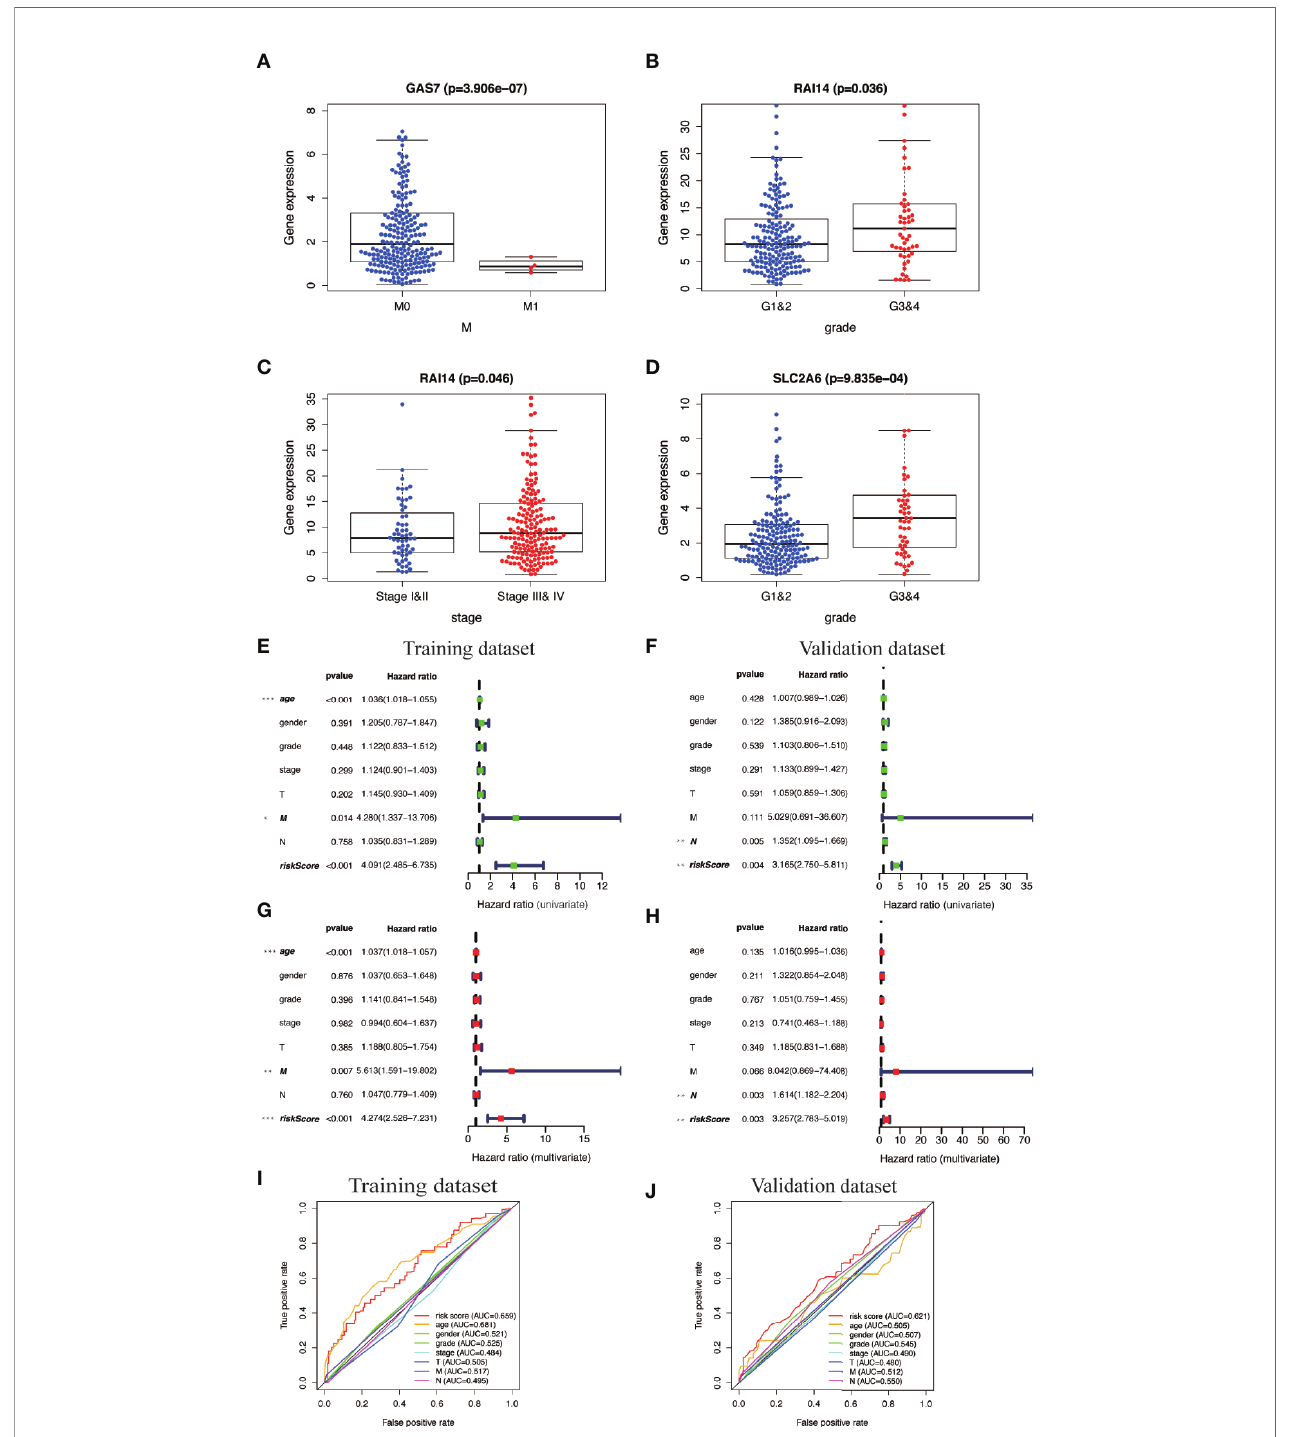
FIGURE 7 | Clinical correlation analysis and independent prognosis analysis of TBGs and clinicopathologic characteristics. (A) Differentially expressed GAS7 in M classi fi cation (M0 and M1). (B, C) Differentially expressed RAI14 in pathologic grade classi fi cation (G1 – 2 and G3 – 4) and TNM classi fi cation (Stage I – II and Stage III – IV). (D) Differentially expressed SLC2A6 in pathologic grade classi fi cation (G1 – 2 and G3 – 4). (E, F) Univariate Cox regression analysis. Forest plot of the association between risk factors and survival of training dataset and validation dataset. (G, H) Multivariate Cox regression analysis. Forest plot of the association between risk factors and survival of training dataset and validation dataset. (I, J) Receiver operating characteristic (ROC) analysis of the sensitivity and speci fi city of the OS for the ten-gene risk score in the training dataset and validation dataset. Note: * P < 0.05, ** P < 0.01, *** P < 0.001, **** P <